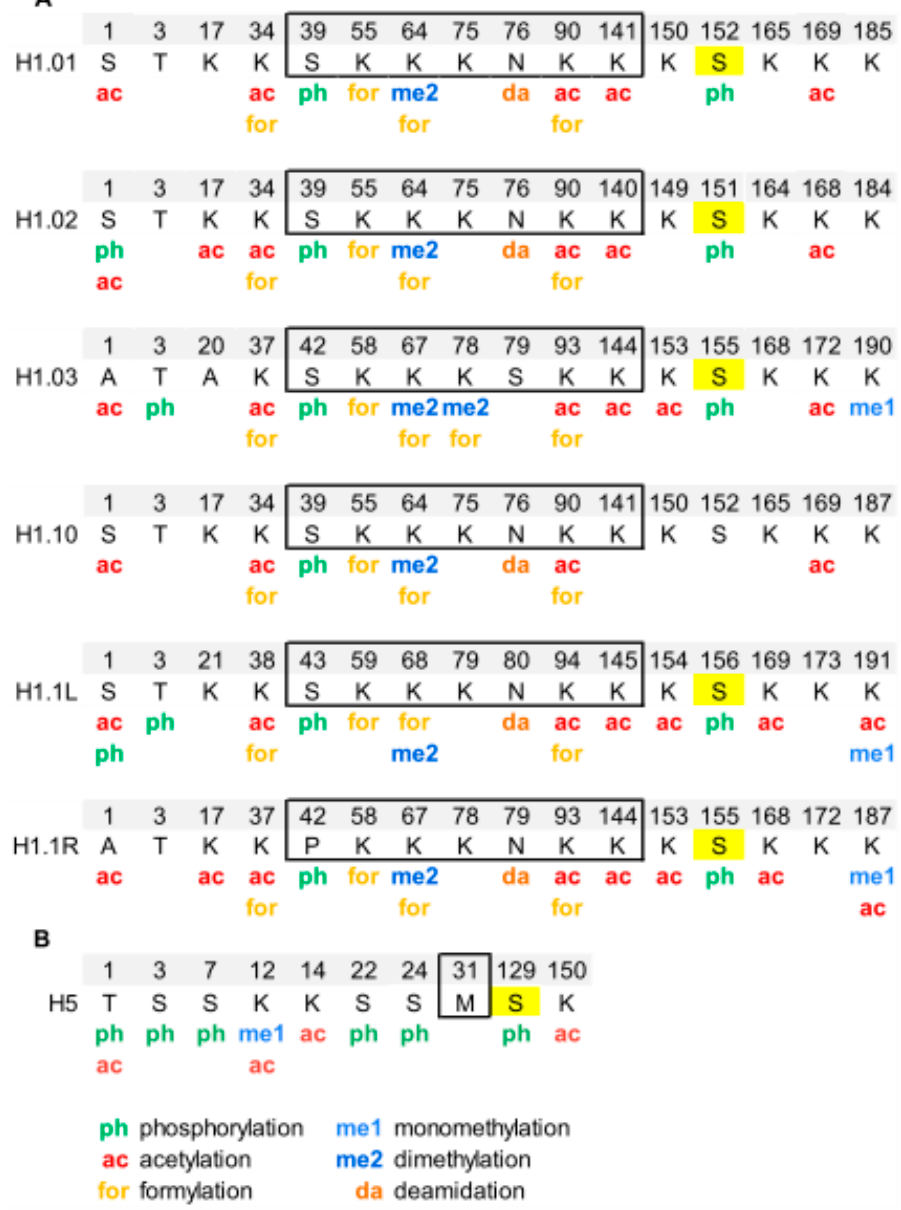
Figure 2. Modified positions in linker histones of chicken erythrocytes. ( A ) PTMs identified in H1 subtypes are shown in the sequence alignment. ( B ) PTMs identified in H5. The residues of the globular domain are shown inside the box. In yellow, phosphorylated residues located at CDK-consensus motifs. The positions refer to the mature protein, which lacks the initial methionine. The complete sequences and the original sequence alignment are shown in Figure S1.